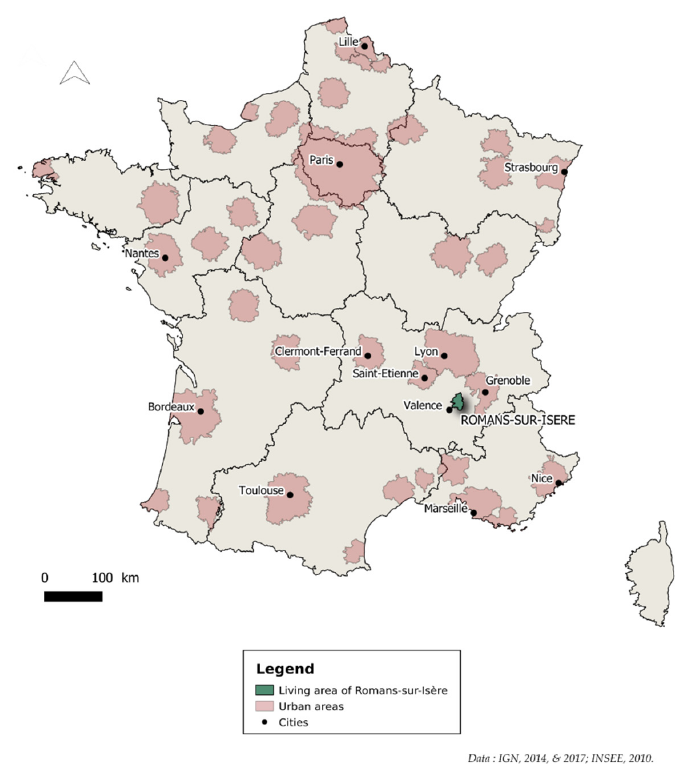
Figure 3. Location of Romans-sur-Isère (source: Authors).